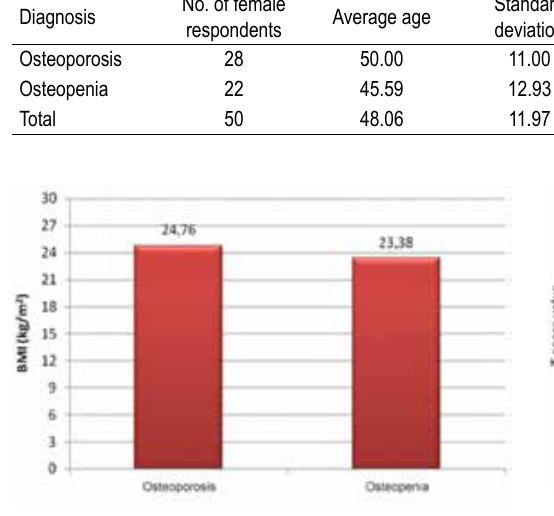
FIGURE 1. the average BMI values of female respondents FIGURE 3. Average values of t-score based on diagnosis